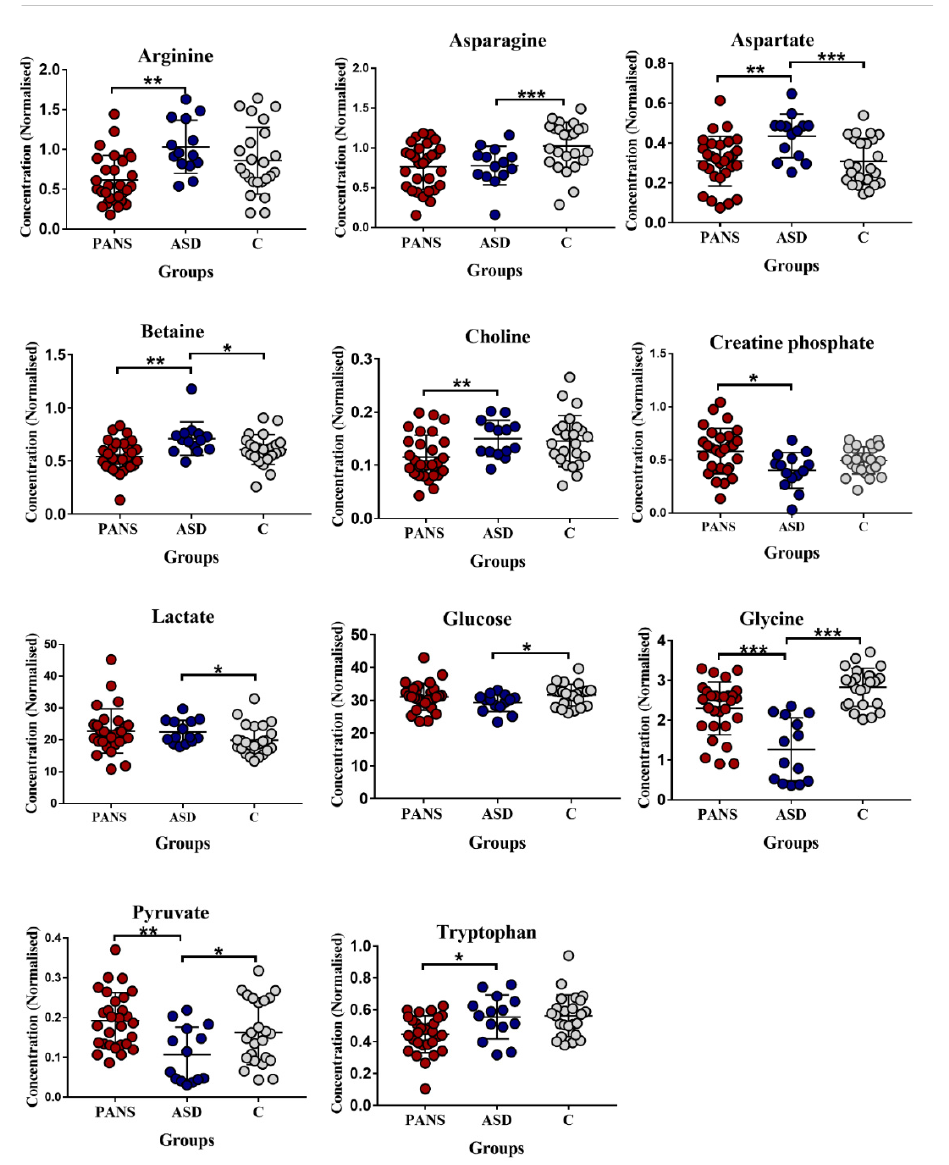
Figure 2. Comparison between controls and ASD and PANS patients. Bar graphs of the metabolites exhibit a p -value of <0.05 (Mann–Whitney U-test). Grey dots represent the control class, red dots represent the PANS class, while blue dots represent the ASD patients. ASD = autism spectrum disorder; PANS = pediatric acute-onset neuropsychiatric syndrome. * p < 0.05, ** p -value < 0.01, *** p -value < 0.001.